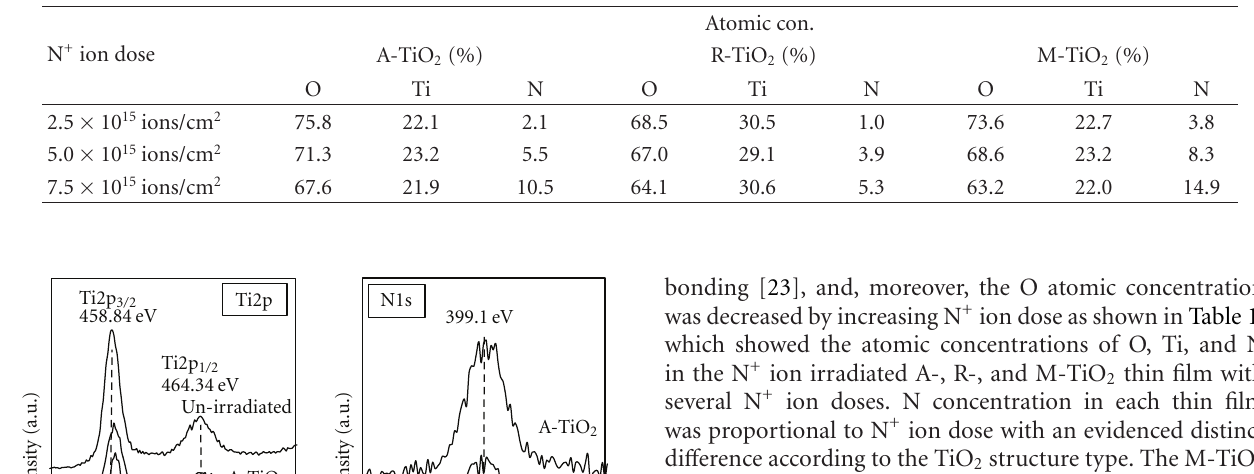
Table 1: O, Ti, and N atomic concentration of the A-, R-, and M-TiO 2 thin films under several N + ion doses.